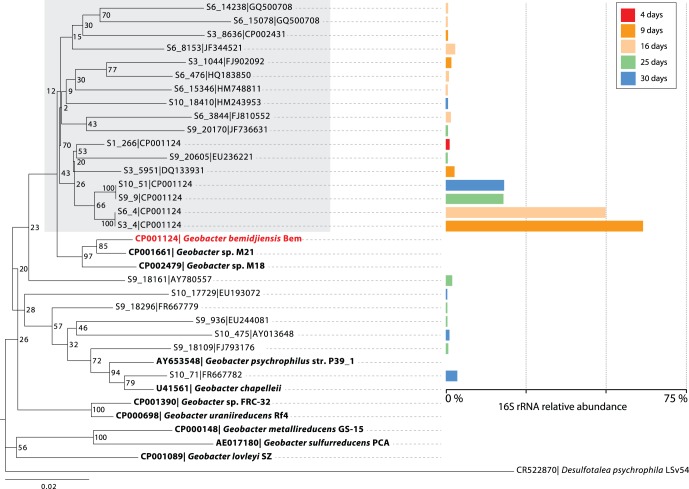
Neighbor-joining phylogenetic tree showing the placement of Geobacter-like environmental 16S rRNA sequences recovered from planktonic biomass at five time-points during carbon amendment.Bolded sequences show the placement of isolate Geobacter 16S rRNA sequences, in the context of the environmental sequences. Sequences within the grey box fall within the G. bemidjiensis/M21/M18 clade, and account for the majority of environmental Geobacter sequences recovered during this study. Accession numbers associated with the environmental sequences correspond to the best match when aligned to SILVA, Greengenes, and the RDP databases.